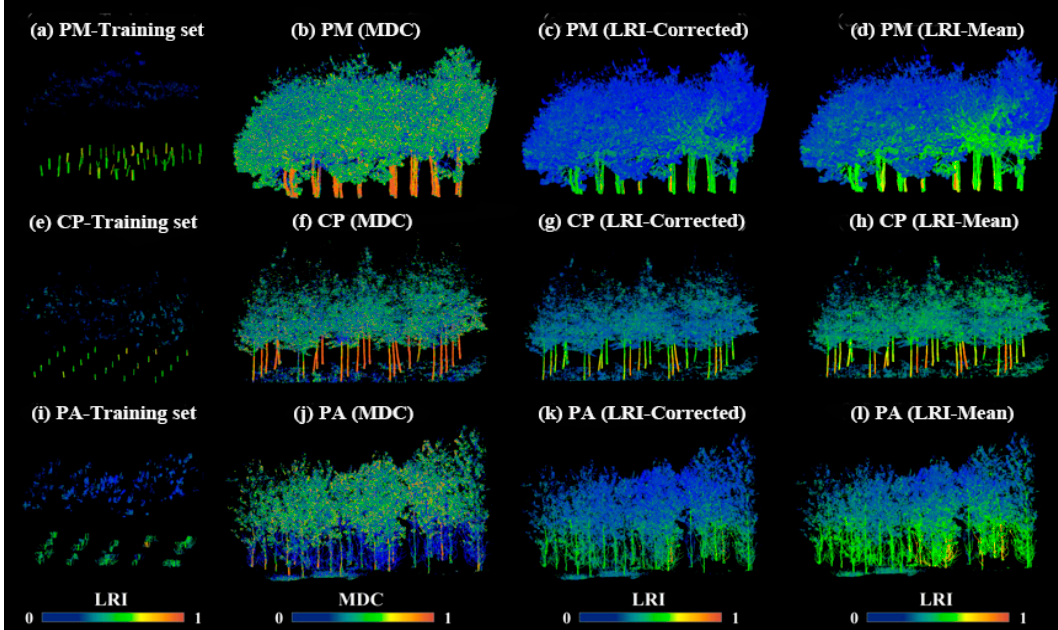
Figure 3. The subfigures ( a ), ( e ), and ( i ) show the training point sets extracted from three TLS datasets to train the FWCNN model. The subfigures ( b ) to ( d ), ( f ) to ( h ), and ( j ) to ( l ) show the feature extraction results of three TLS datasets, including the morphological detection coefficient (MDC), the corrected LRI information of each point (LRI-Corrected), and the pointwise local mean LRI (LRI-Mean).